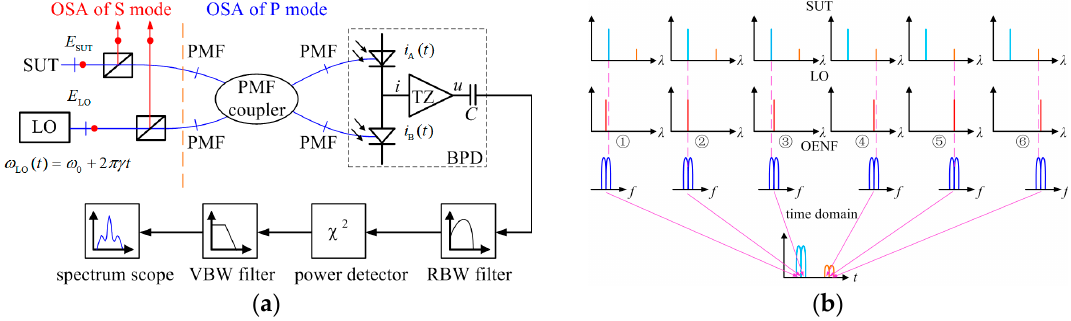
Figure 1. ( a ) Schematic diagram of the OENF system; ( b ) Working process of the OENF system.